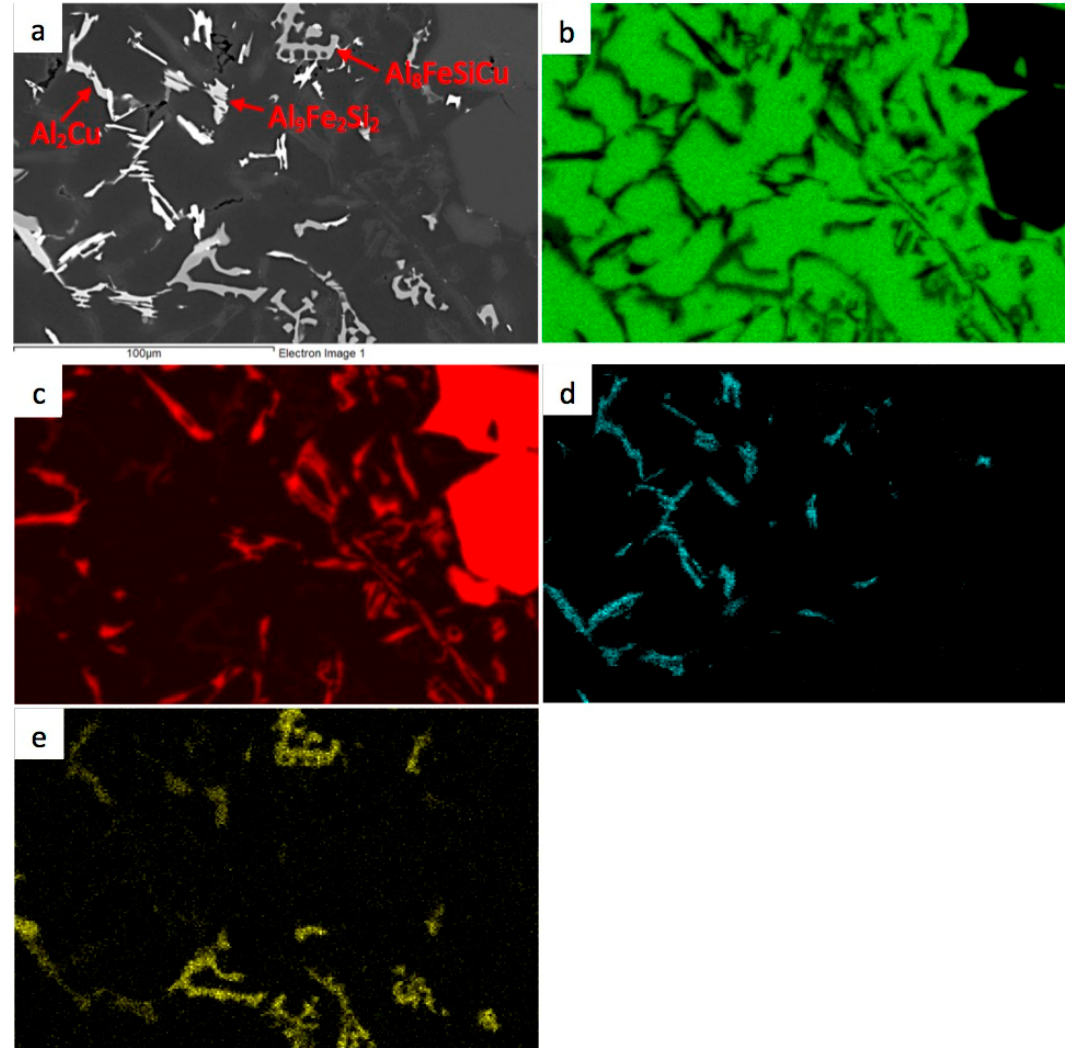
Figure 6. ( a ) SEM image of solidification microstructure and EDX maps of ( b ) Al, ( c ) Si, ( d ) Cu and ( e ) Fe in intermetallic phases for the conventionally cast Al-18%Si-2%Cu alloy. Table 1. The chemical composition of intermetallics in the studied Al-18%Si-2%Cu samples, at.%. Calculated formula Suggested formula